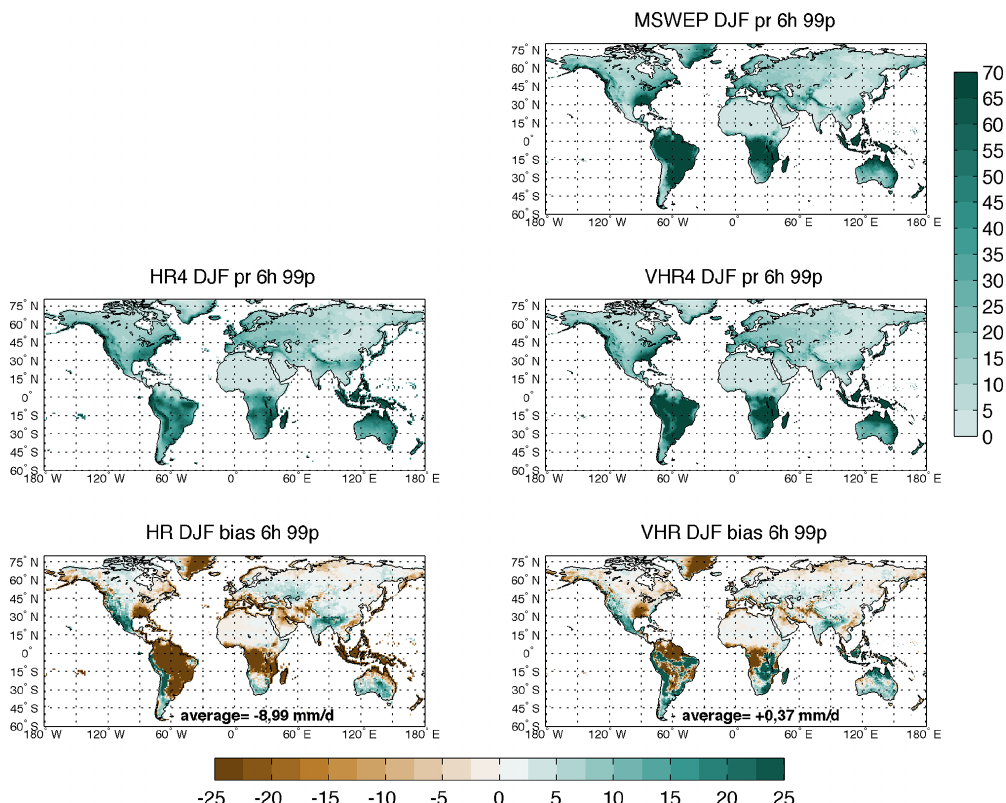
Figure 7. Winter (DJF) extreme precipitation (99th percentile, 99p) computed at the 6-hourly frequency. Upper panel shows MSWEP observational results. Central panels show model results (HR on the left and VHR on the right) and lower panels show the relative model bias. Units are [mmd − 1 ]. Vertical color bar refers to the three upper panels, while the horizontal color bar refers to the two bottom